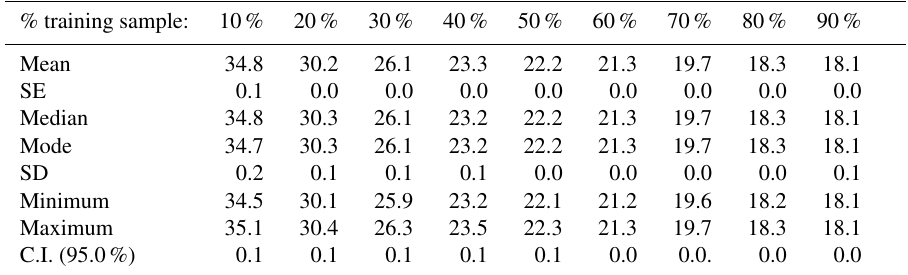
Table B1. Descriptive statistics of MSR from different training set sizes, after 10 iterations with default settings.